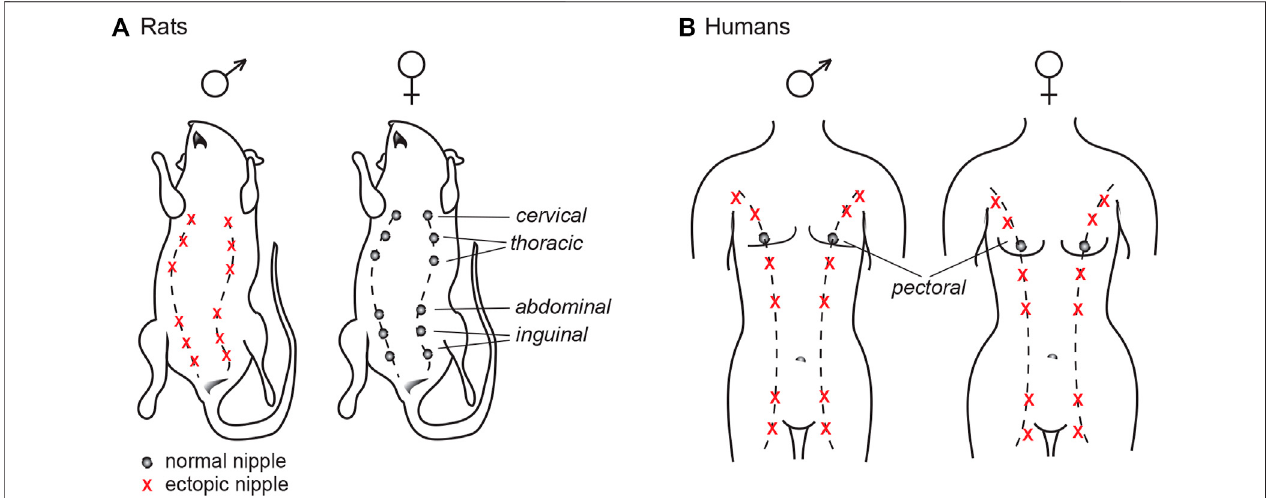
FIGURE4| Themammalianmilkline,ormammaryridge. (A) Incommonlaboratoryrats(suchasWistarandSpragueDawley),nippleswillonlydevelopinthefemaleoffspring,as androgen signaling during development prompts the nipple anlagen to regress in males. (B) Humans have auxiliary mammary ridges, but only the two central pectoral nipples will develop. Contrary to rats, both sexes have the same number of